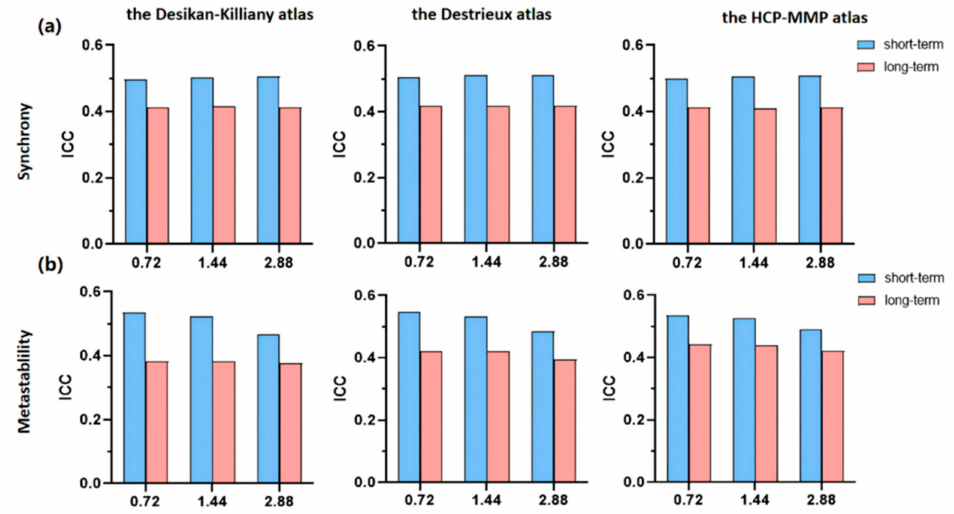
Figure 3. Reliabilities of synchrony ( a ) and metastability ( b ) in different temporal resolutions, evalu- ated by the intraclass correlation coefficient (ICC). Blue bars represent short-term reliability and pink bars represent long-term